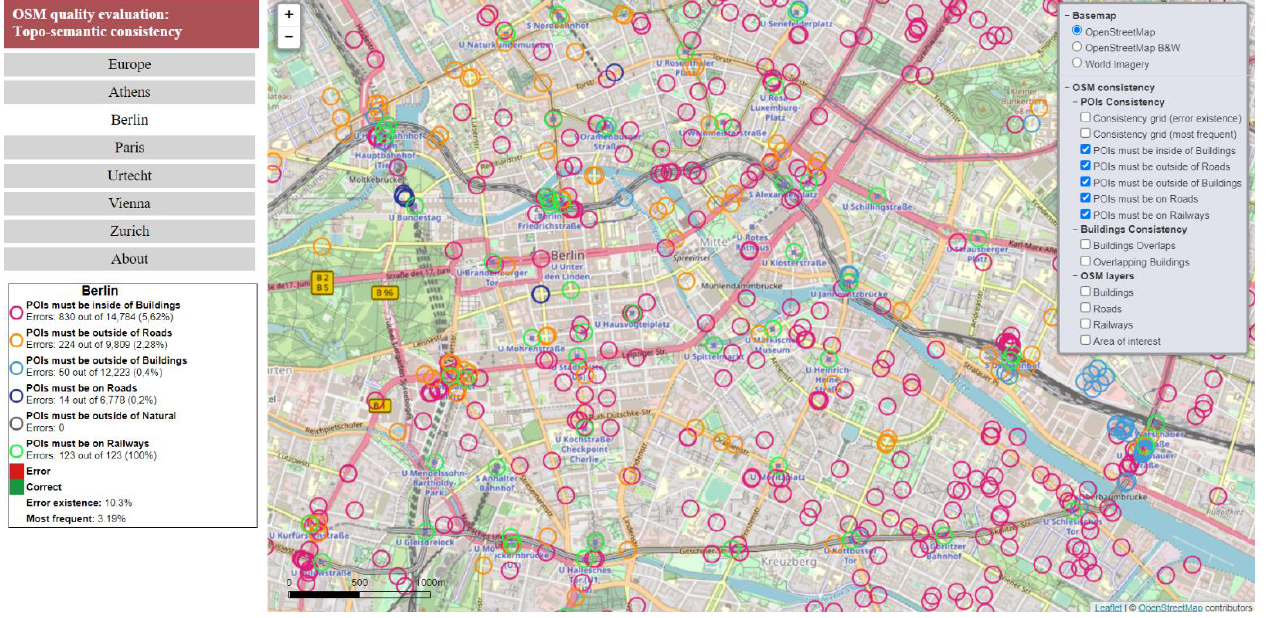
Figure 10. Errors from the topo-semantic consistency (Berlin) checks, symbolized with circles with different colors for each check as explained in the legend.